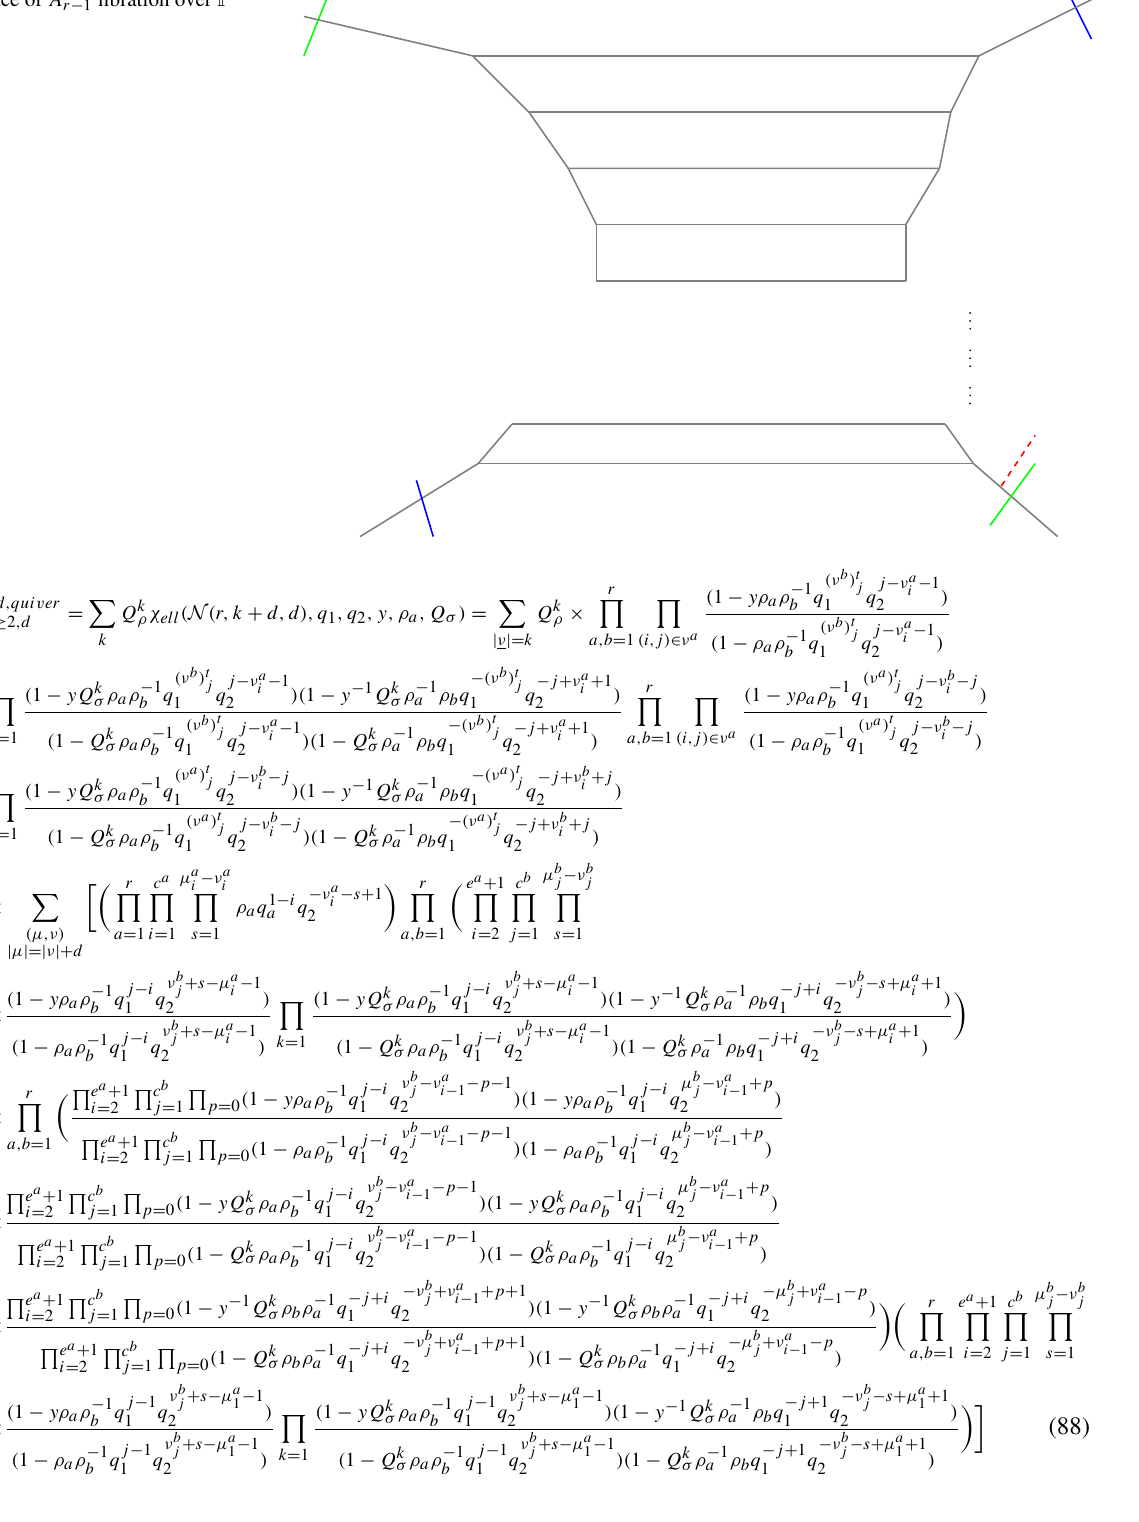
Fig. 10 Fully compactified web diagram of the the total space of A r − 1 fibration over P